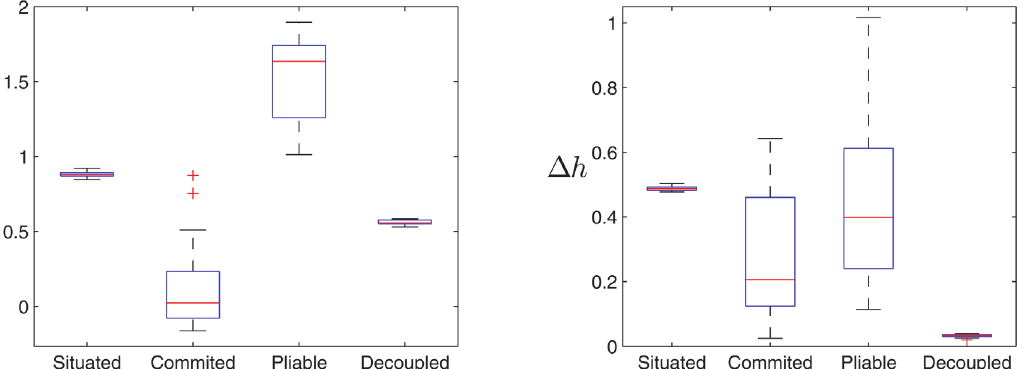
Fig 8. Fractal exponents and width of the multifractal spectrum of the four types of agents. Only situated agents present both a pink noise exponent and a wide multifractal exponent. Decoupled agents appear to present a 1/ f exponent but this is a misleading sign of SOC because they show no